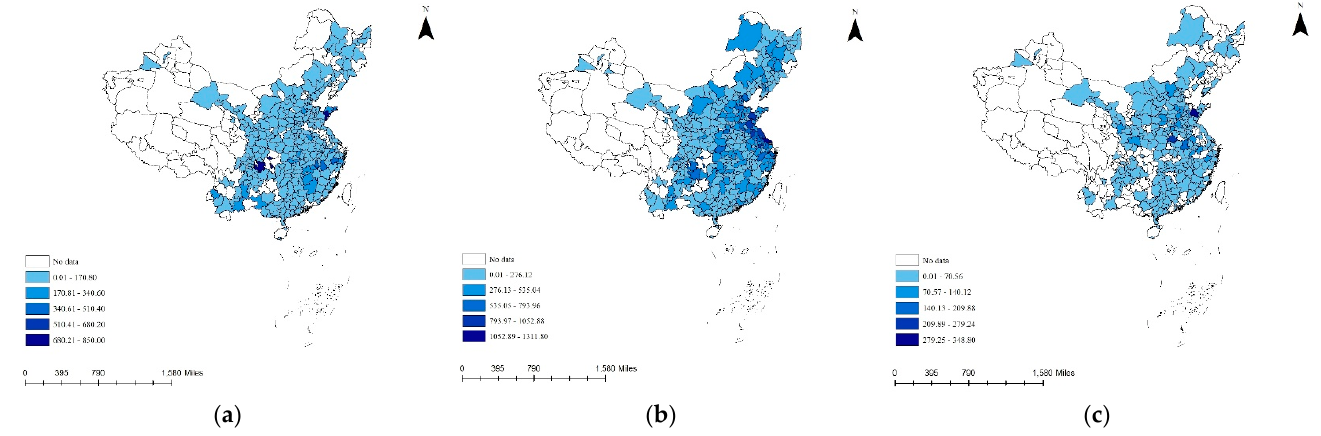
Figure 5. The spatial distribution of land transaction modes in the study area from 2010–2016. ( a ) The mode of auctions. ( b ) The mode of listing. ( c ) The mode of bidding.